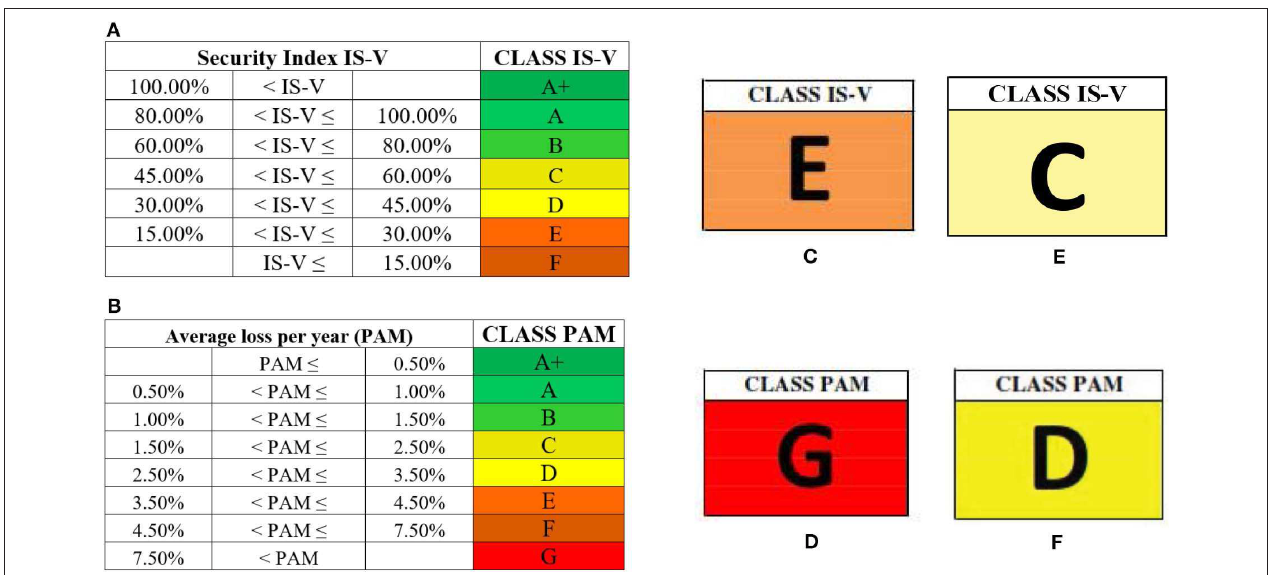
FIGURE 7 | (A) Life Safety Index (Indice di sicurezza della vita, IS-V) risk classes definition. (B) Expected annual mean losses (Perdite Annue medie, PAM) risk classes definition. (C) IS-V class before upgrading. (D) PAM class before upgrading. (E) IS-V class after upgrading. (F) PAM class after